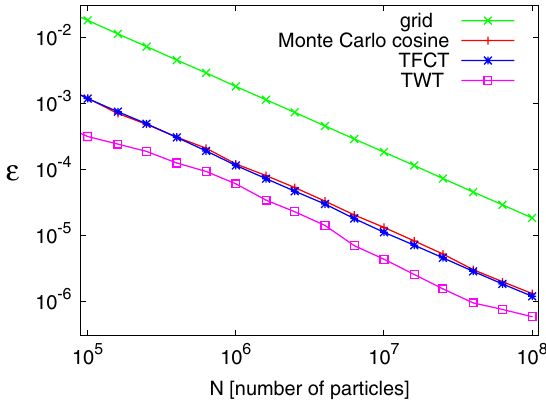
FIG. 10. Accuracy (measured by the IMSE) as a function of the number of particles N for the approximations of the flattop distribution with (cid:8) ¼ 100 (cid:9) m modulations: Monte Carlo cosine (red), grid (green), FCT on a grid (blue), and grid with wavelet denoising, using Daubechies wavelets of order 10 (purple). The ¼ 1024 , N ¼ 128 , and the number of cosine resolution is N z x basis functions is 100 and 40 in z and x directions, respectively.